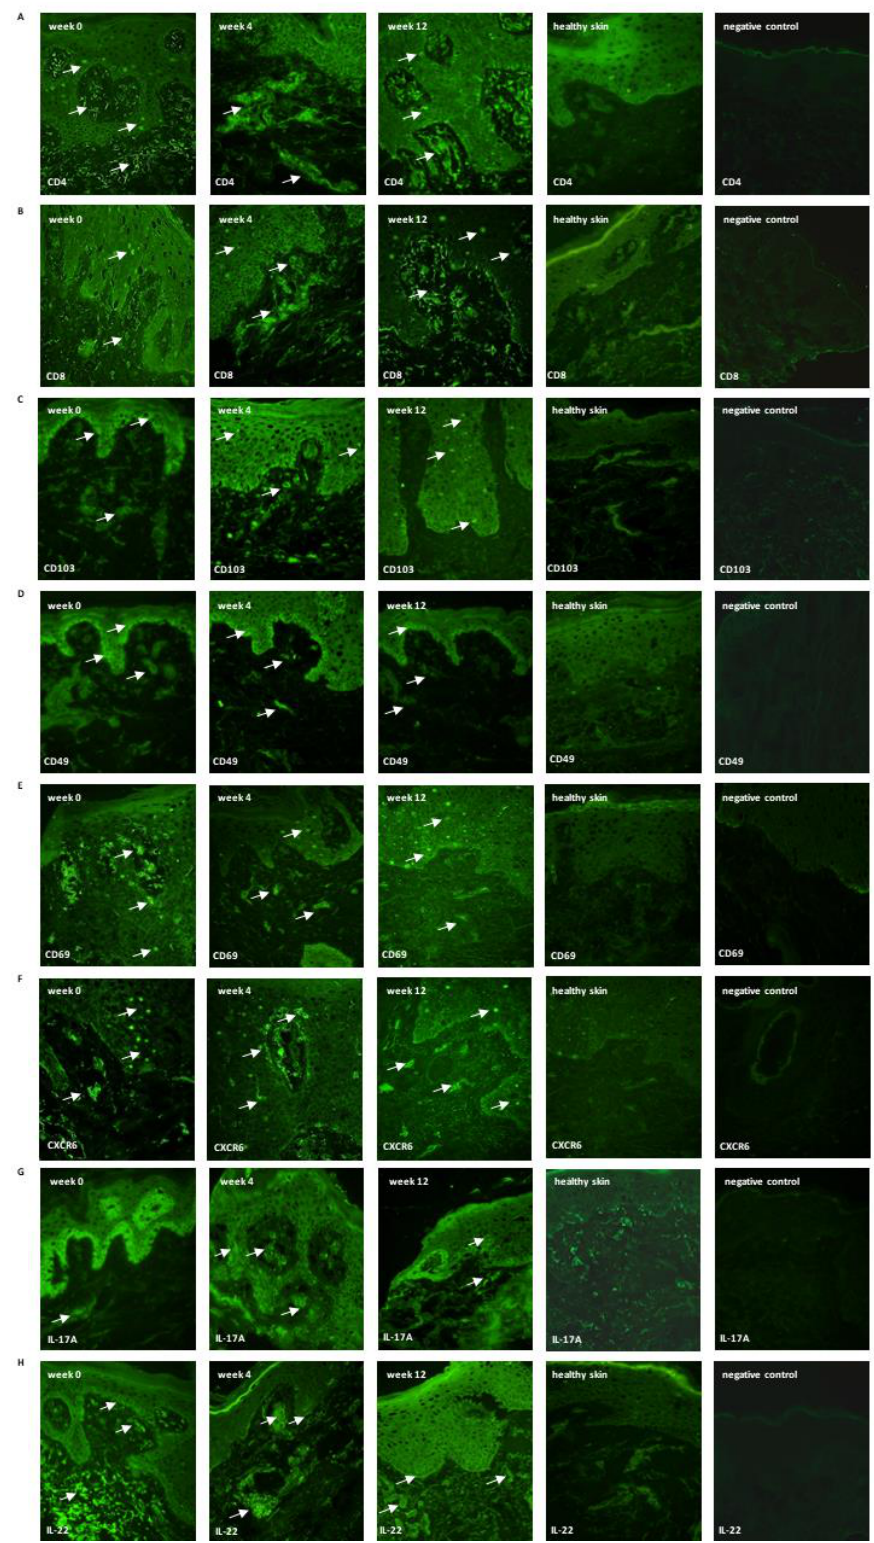
Figure 2. Skin localization of ( A ) CD8, ( B ) CD4, ( C ) CD103, ( D ) CD49, ( E ) CD69, ( F ) CXCR6, ( G ) IL-17A, ( H ) IL-22 (the representative sections): lesional skin during week 0, 4, and 12 ( n = 10); healthy skin ( n = 10) and negative control (without primary antibody). The proteins are marked in green (white arrows, fluorescein). Magnification: 500×.